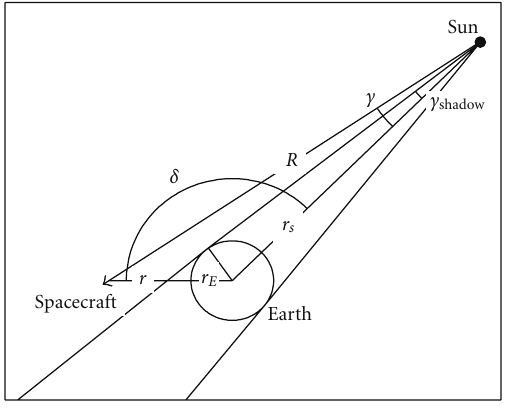
Figure 2: Schematic geometry of the Earth shadow.